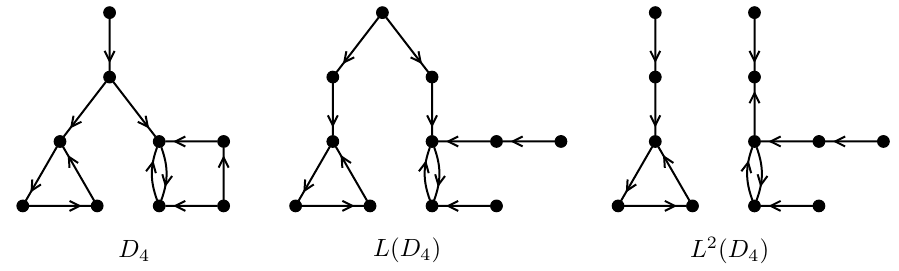
Figure 14: An example of line iterates of a digraph with no joined